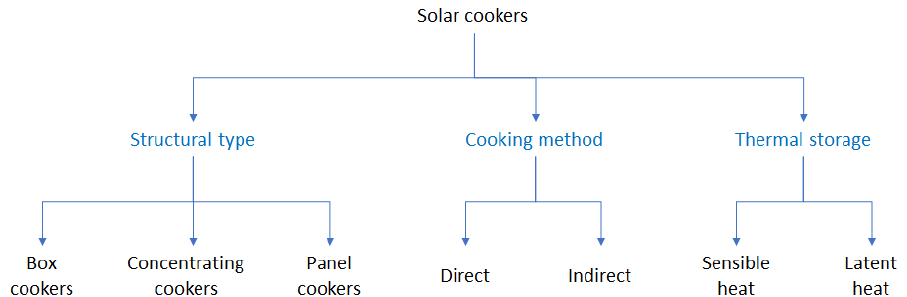
Figure 1. A general classification of solar cookers [28]. This classification is based on how thermal energy from the sun is transferred to the cooking vessel. It is important to clarify that in this context the “cooking method” is “indirect” when the sun’s energy is captured by a part of the system and then transferred to the cooking box by means of specific fluid having a high thermal capacity (Figure 2).